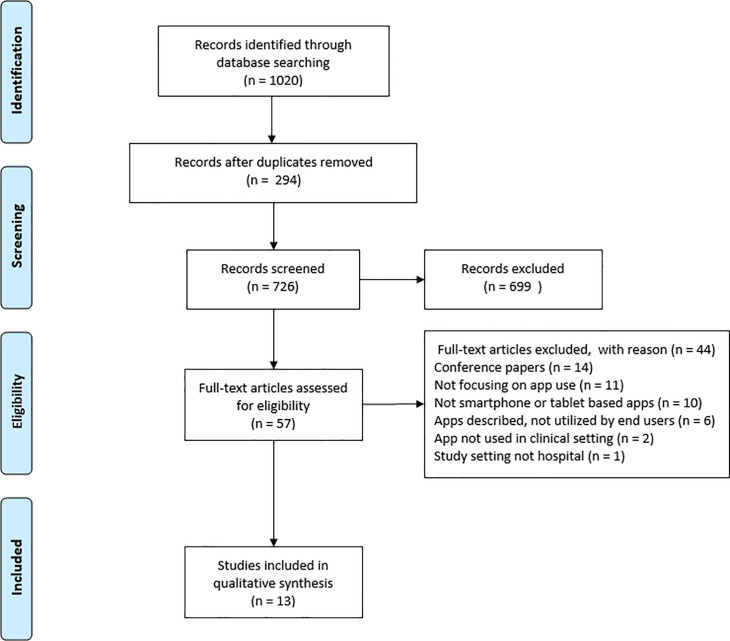
Study selection.